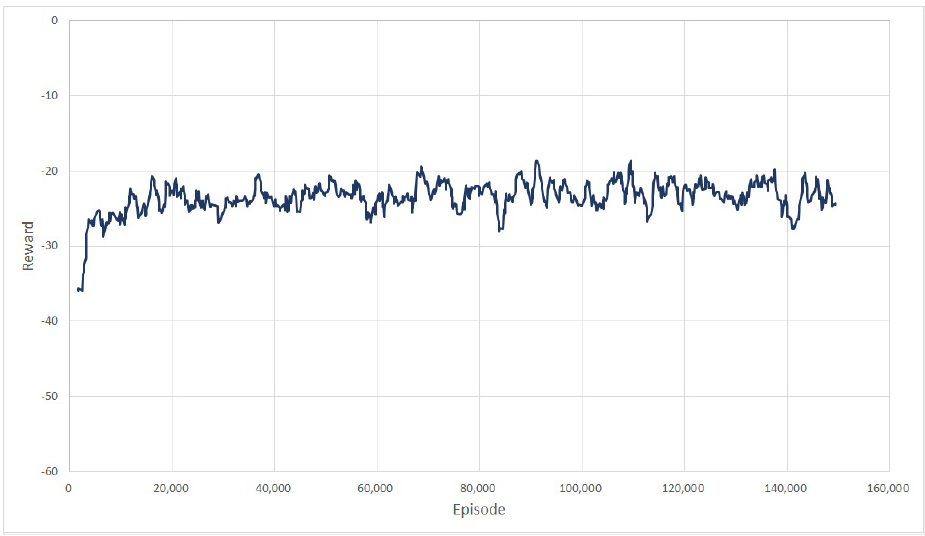
Figure 10. 3-DOF manipulator: reward from learning.